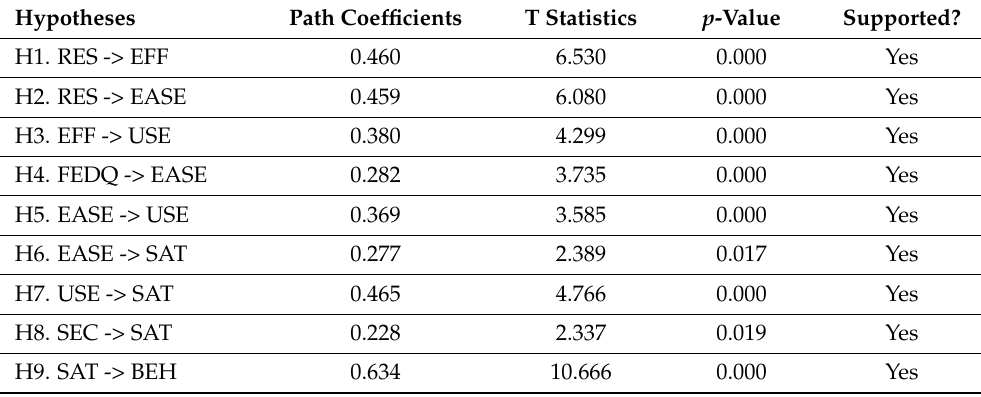
Table 7. Results of hypotheses testing.